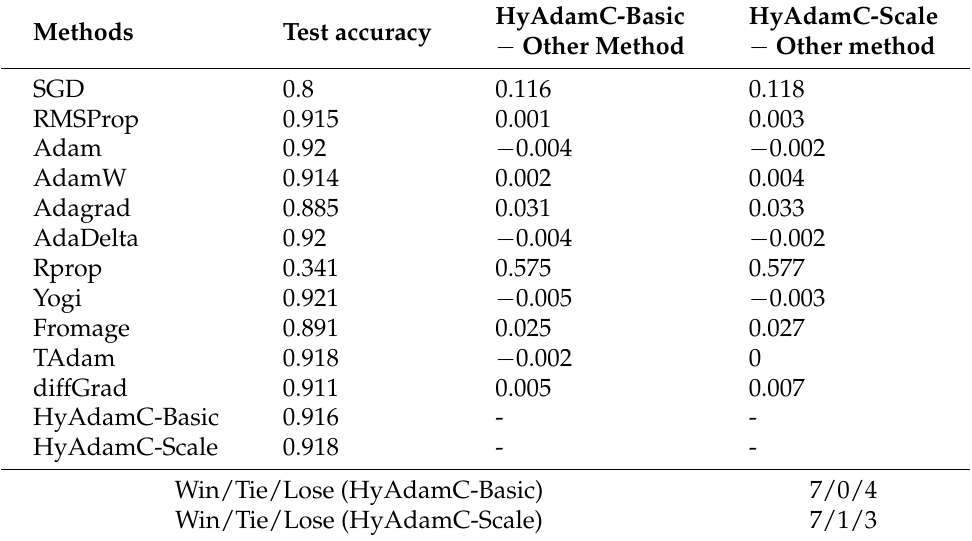
Table 9. The test accuracies of the MobileNet-v2 trained by the optimization methods for the CIFAR- 10 image dataset classification task. “ HyAdamC-Basic − Other Method ” (or “ HyAdamC-Scale − Other Method ”) indicates a difference between the test accuracies of HyAdamC-Basic (or HyAdamC-Scale) and the compared method. “W (Win)”, “T (Tie)”, and “L (Loss)” refer to the number of the compared methods for which HyAdamC-Basic (or HyAdamC-Scale) achieved better, equivalent, and worse test accuracies, respectively.